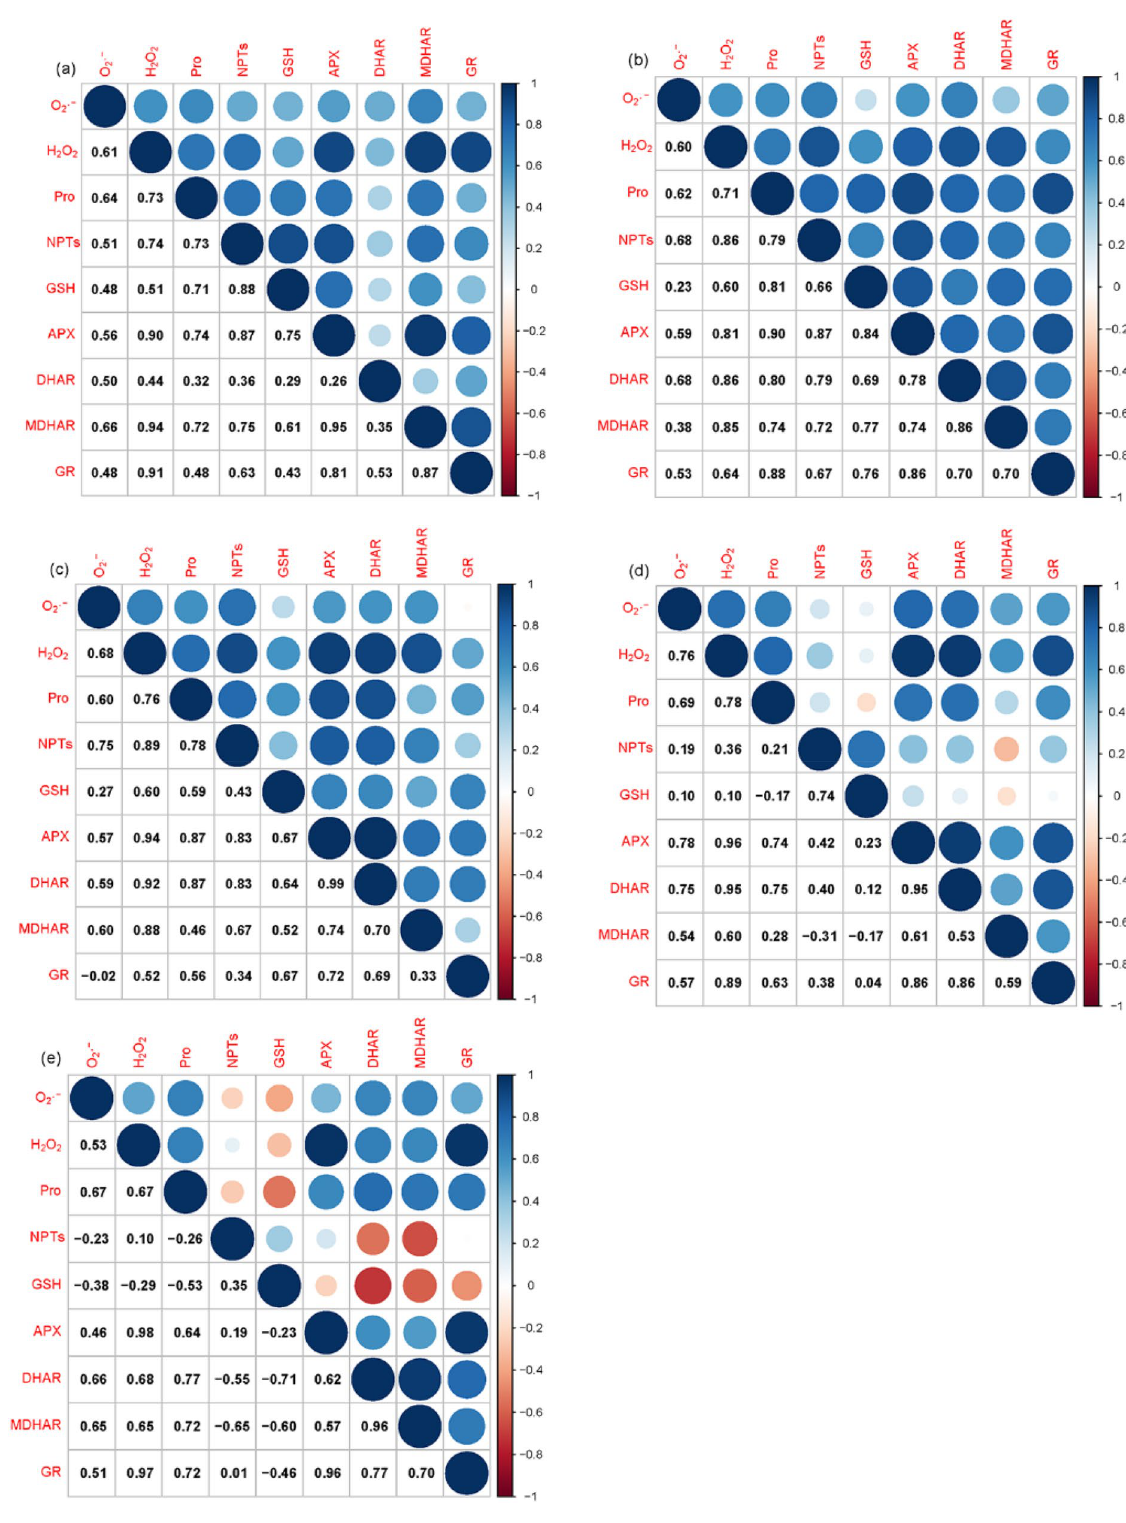
Figure 5. The Pearson correlation coefficients among the measured variables in leaves of Lonicera japonica Thunb. cuttings exposed to different Cd treatments. ( a ) 10 mg kg −1 Cd; ( b ) 30 mg kg −1 Cd; ( c ) 80 mg kg −1 Cd; ( d ) 150 mg kg −1 Cd; ( e ) 200 mg kg −1